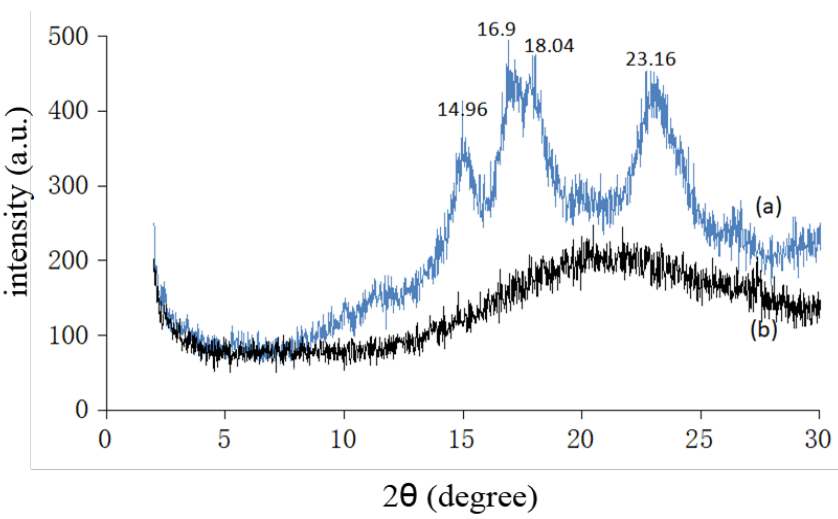
Figure 6. XRD patterns for ( a ) sago starch, and ( b ) cationic sago starch with DS = 1.195.